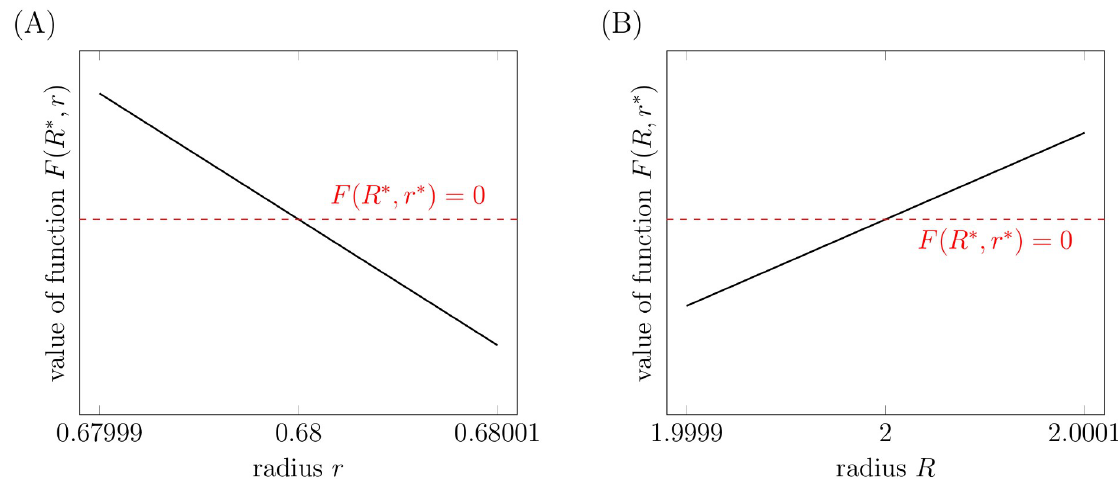
Fig 6. Local stability of the steady state. Both plots present values of the function F ( R , r ). In (A) we set R = R � , in (B) we set r = r � . The dashed red lines correspond to F ( R � , r � ) = 0. All calculations were done for mesh size N = 50 (90404 degrees of freedom). Also the value F ( R � , r � ) is calculated using the value of pdbasic corresponding to the mesh size N = 50.